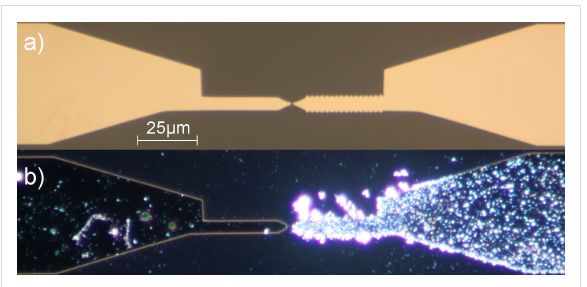
Figure 6: (a) Optical microscope picture of a MCBJ before electro- chemical deposition of Ag (bright-field illumination). (b) Optical micro- scope picture after the deposition of Ag (dark-field